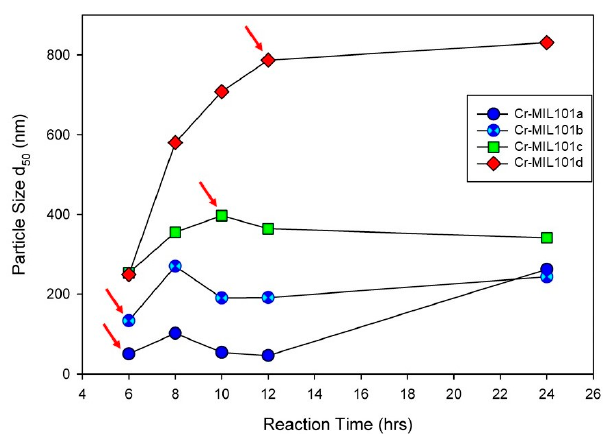
Figure 1. Particle size (d 50 ) of Cr-MIL-101 synthesized under 1 mM to 4 mM precursor dosage with increasing reaction time from 6 h to 24 h, demonstrating tunability of grain sizes of Cr-MIL-101. Arrows refer to specific morphologies of Cr-MIL-101 combined with Da to form MOF-Da